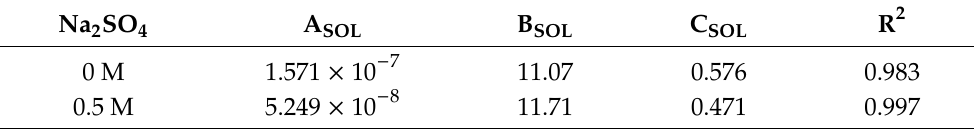
Figure 4. Influence of the pH value and sodium sulfate on the solubility of succinic acid at 20°C. Symbols ( ■ ● ) are measured concentrations and lines are calculated by Equation (16). The literature data ( ⭑ ) are calculated from [23,24]. Table 1. Solubility curve parameters fitted to Equation (16) for succinic